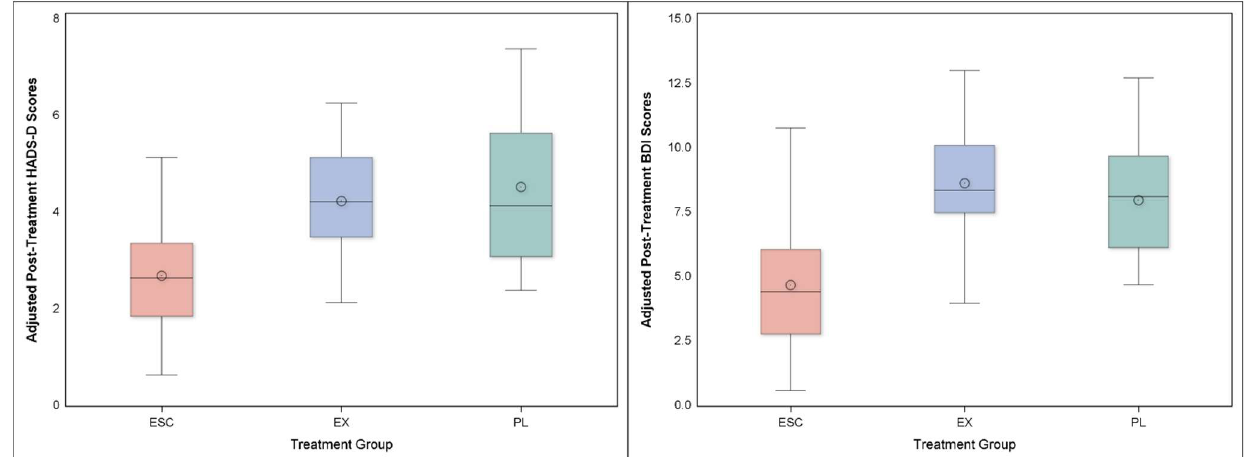
Figure 2. Comparison of scores on the HADS-D (left panel) and BDI-II (right panel) by treatment group at one year. Adjusted HADS-D and BDI-II Scores at 1-year follow-up revealed that participants in Escitalopram (ESC) had lower scores on the HADS-D ( P = 0.004) and lower scores on the BDI-II ( P = 0.004) compared to those participants randomized to Exercise (EX). It should be noted that depression scores were still lower for all groups compared to their pre-treatment levels for the BDI-II (baseline Exercise = 16.2; Escitalopram = 15.2; Placebo 17.7) and HAM-D (baseline Exercise = 6.4; Escitalopram 6.7; Placebo = 7.0). Multiple regression analyses were used with 1-year outcomes serving as the outcome variables for the HADS-D and BDI-II respectively, controlling for the pre-treatment level of the respective outcome, age, sex, race, baseline diagnosis of anxiety disorder, history of myocardial infarction, and treatment group as the predictor of interest.